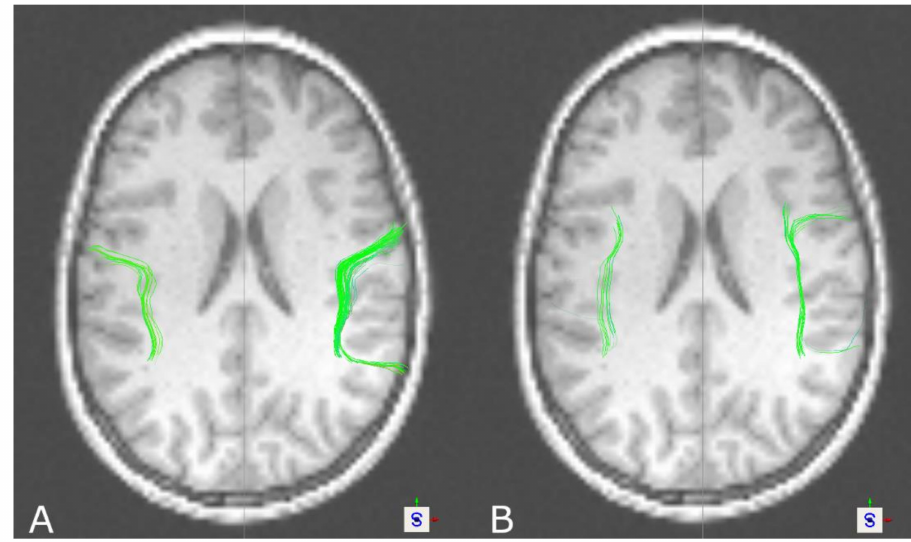
Figure 4. Tractography results of the AF for a healthy volunteer based on DTI ( A ) and DKI ( B ), showing more solid and compound tract reconstructions based on DTI (axial